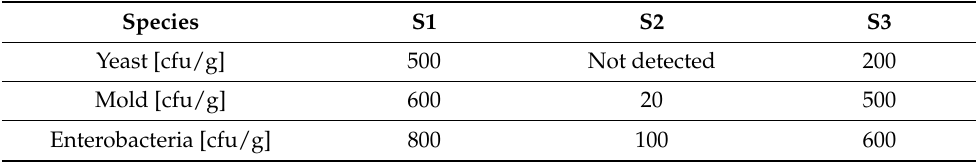
Table 1. Microbiological